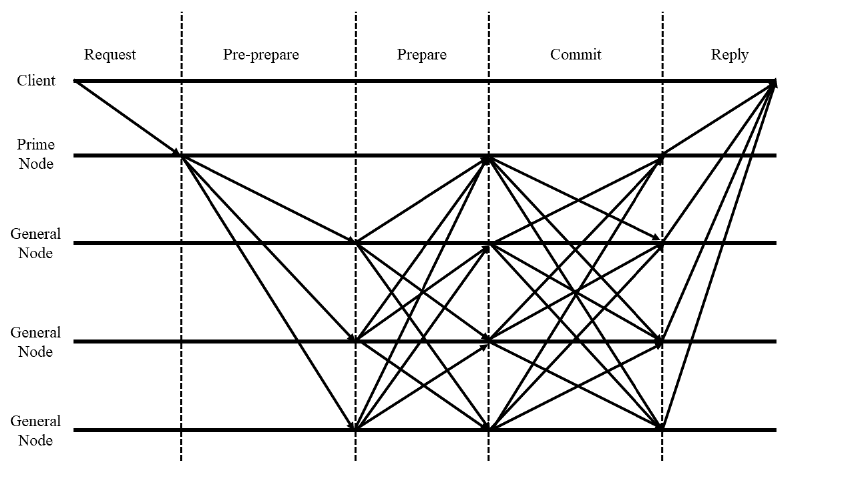
Figure 1. The consensus process of the PBFT consensus